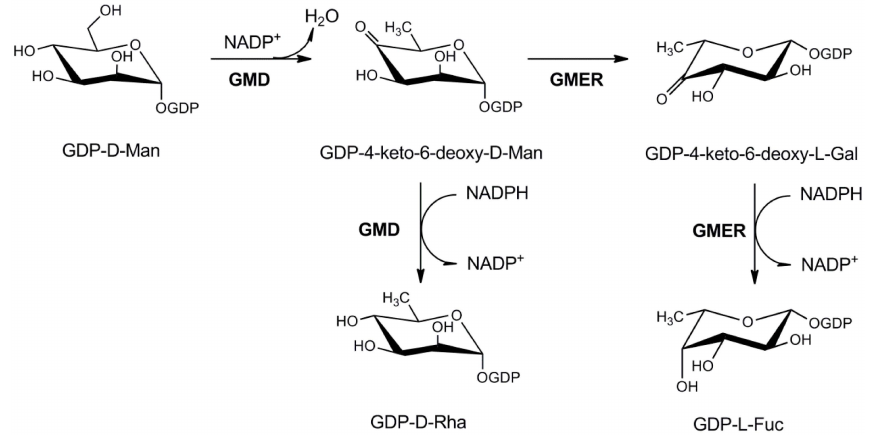
Figure 2. Metabolism of GDP- D -rhamnose and GDP- L -fucose in PBCV-1. PBCV-1 GMD is bifunctional, with both dehydratase and NADPH-dependent reductase activities, leading to GDP- D -rhamnose formation. GMER is a GDP-4-keto-6-deoxy- D -mannose 3,5-epimerase/4-reductase producing GDP- L